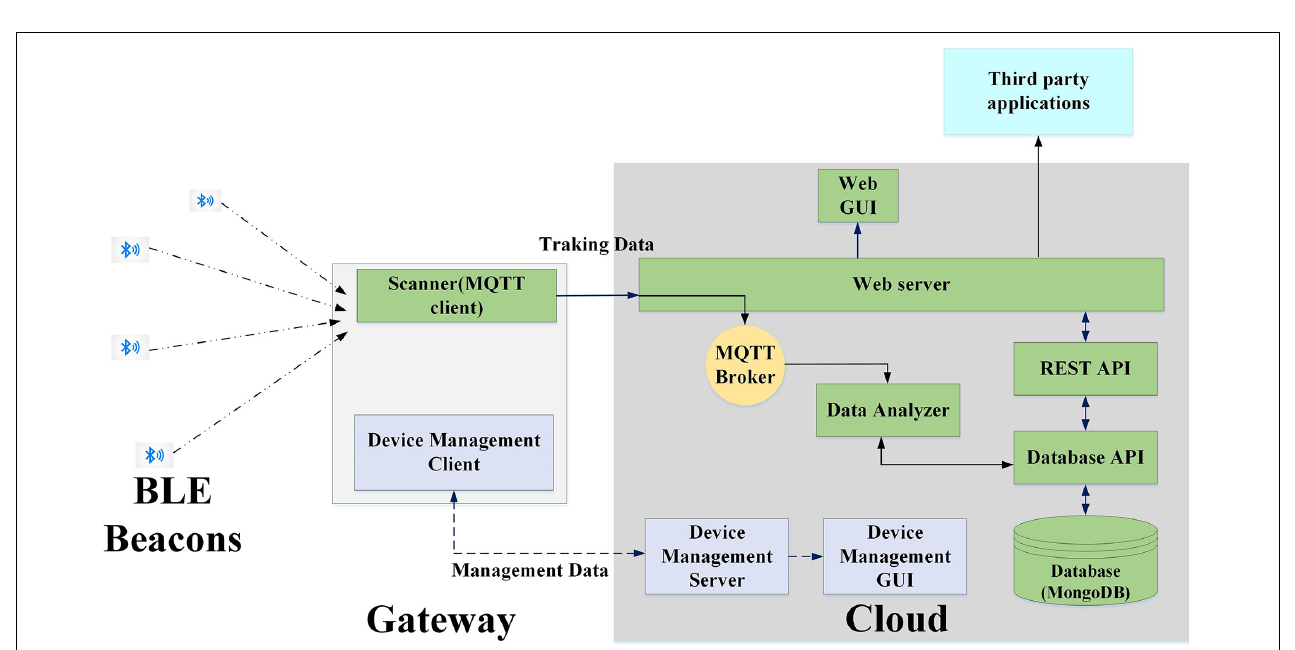
FIGURE 1 | The architecture of indoor tracking application for a construction site (adapted from Zhao et al., 2019).